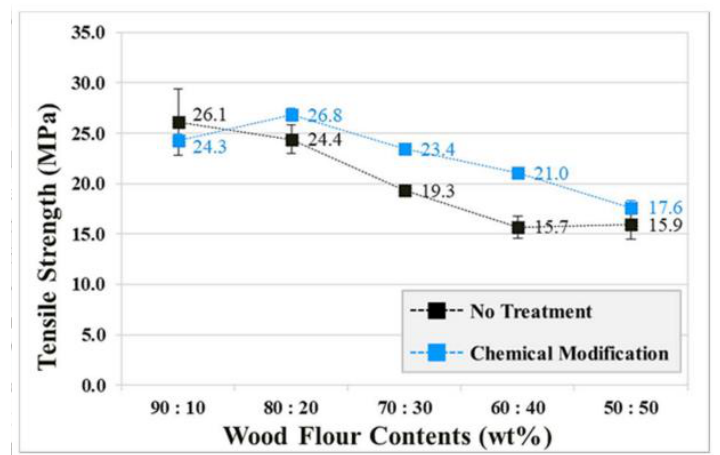
Figure 10. Tensile strengths of chemically modified and untreated wood-plastic composite injection-molded ASTM specimens.